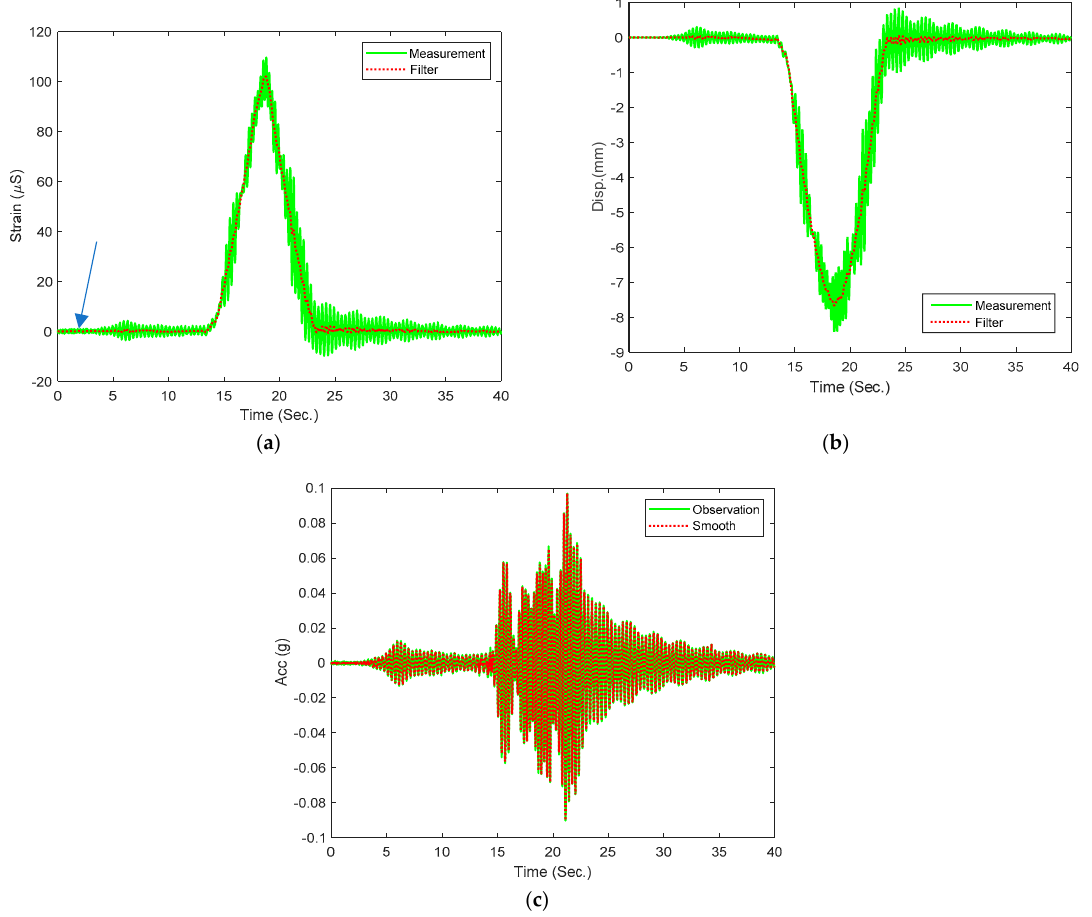
Figure 6. Measurements and filtration under 20 km/h ( a ) strain, ( b ) displacement and ( c ) acceleration.